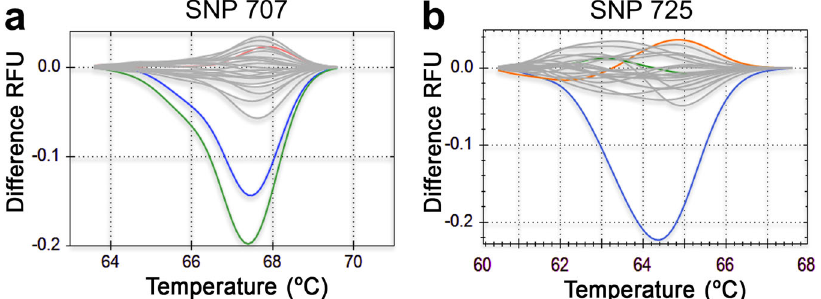
Fig. 4 High-Resolution Melting (HRM) analysis of Pfs47 SNPs 707 and 725 in fi eld samples from Africa (gray). a HRM difference curves for Pfs47 SNP 707 in 20 dry blood spots from Kalifabougou, Mali, Africa. b HRM difference curves for Pfs47 SNP 725 in 20 dry blood spots from Kalifabougou, Mali, Africa. Reference sequences from Africa (GB4 orange), Asia (Thai 17, green), and New World (7G8 blue) are also